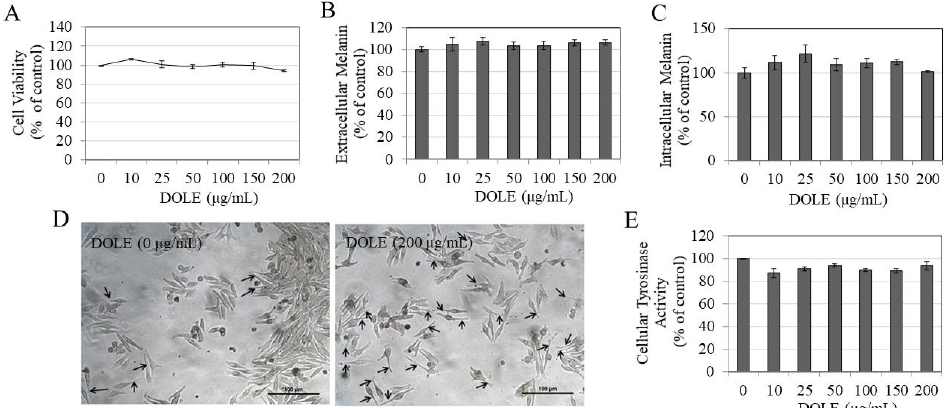
Figure 2. ( A ) Viability of MNT-1 human melanoma cells treated with different concentrations of DOLE for 48 h; data are mean ± SEM of three independent experiments. ( B ) Extracellular melanin and ( C ) intracellular melanin levels in cultures of MNT-1 cells treated for 48 h with different concentrations of DOLE; data for ( B , C ) are mean ± SEM of values from one representative experiment out of two experiments. ( D ) Representative images of MNT-1 cells for untreated and DOLE-treated groups, where elongated dendrites are shown by black arrows; ( E ) cellular tyrosinase activity in lysates of MNT-1 cells; data are mean ± SEM of three independent experiments; one-way ANOVA with Dunnett’s post hoc test.